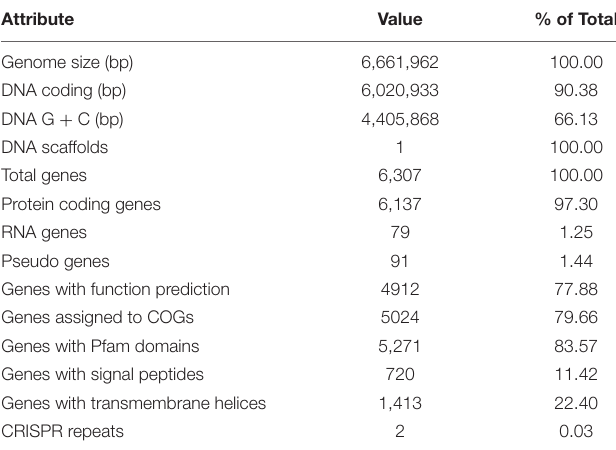
TABLE 1 | General features of the genome of P. aeruginosa strain